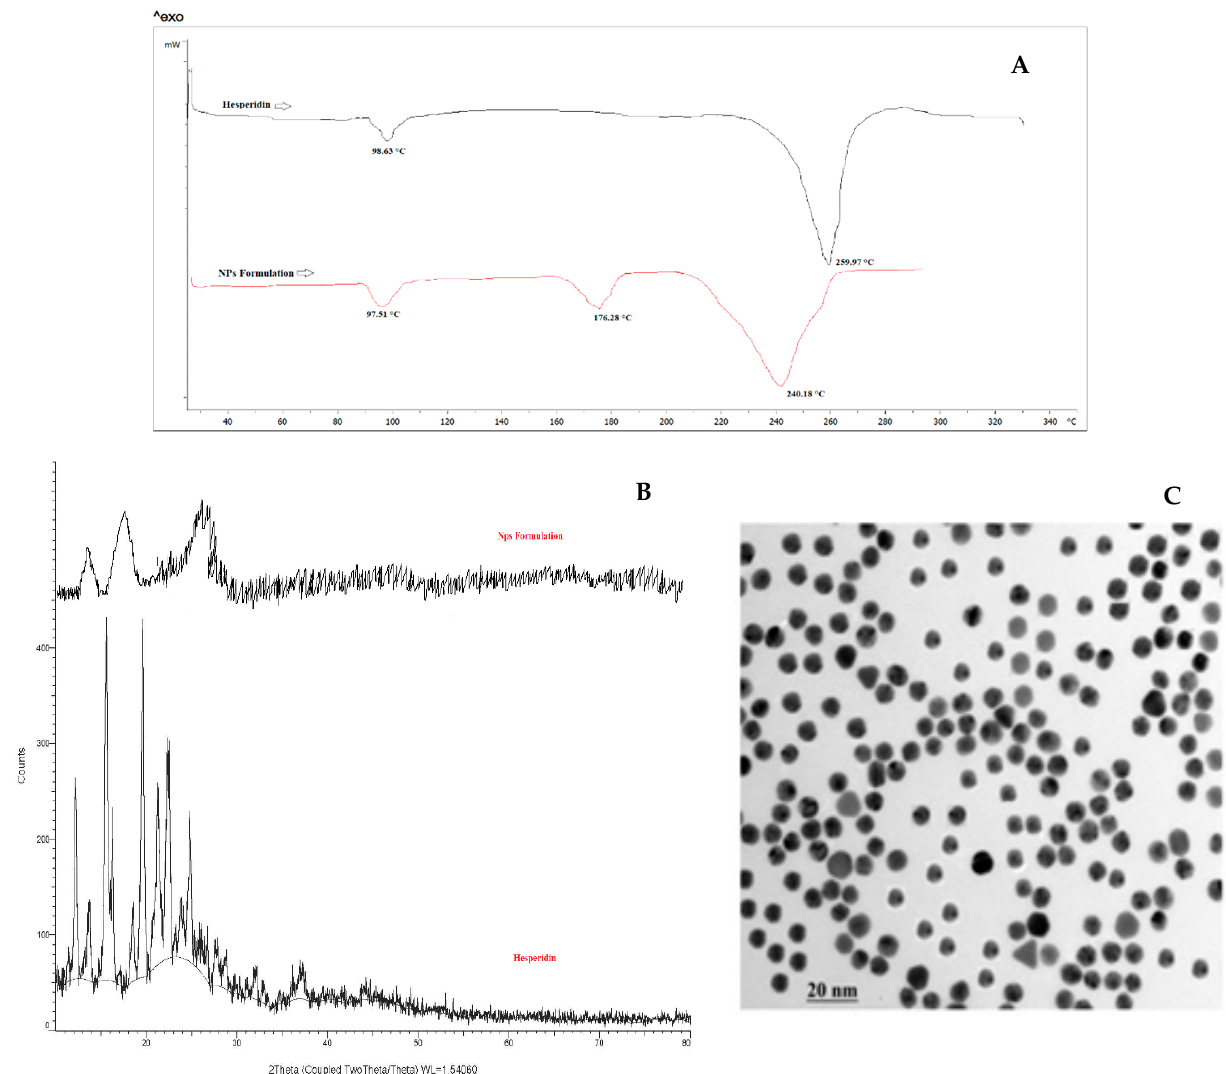
Figure 5. Hesperidin-loaded lipid polymer hybrid nanoparticle: ( A )—DSC; ( B )—XRD; ( C )—TEM analysis.